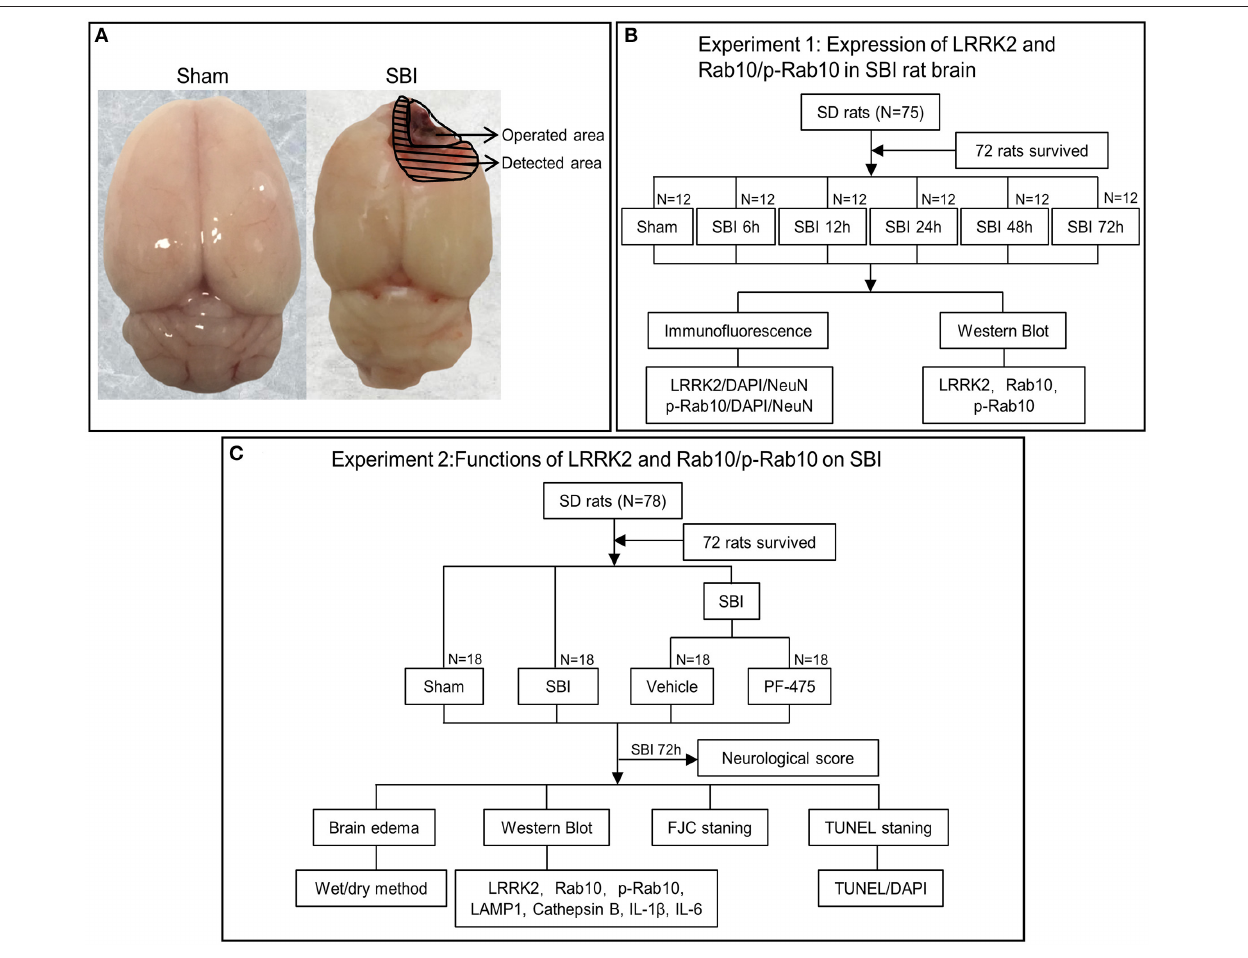
FIGURE 1 | Experimental design. (A) Brain tissue was obtained from the same site (peripheral lesion) in the SBI group and the Sham group for measurement. (B) Experiment 1 was to prove the expression level and location of LRRK2, Rab10, p-Rab10 after SBI, and to determine the appropriate time point for Experiment 2. (C) Experiment 2 aimed to observe the effect of LRRK2/p-Rab10 on early brain injury after SBI and explore its potential